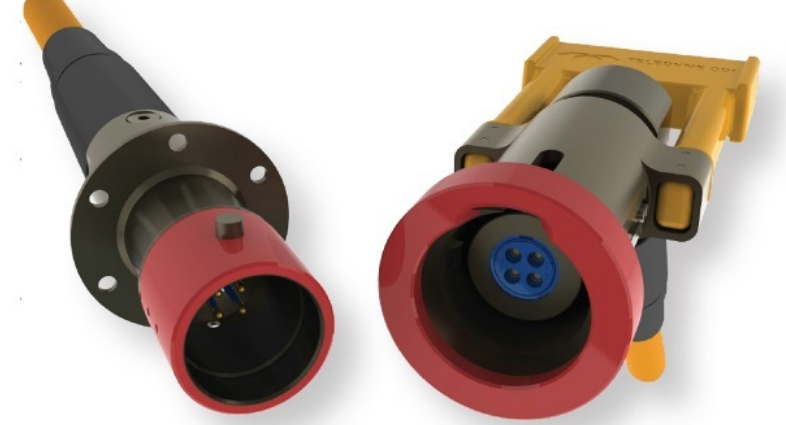
Figure 5. The Nautilus TM WM1.7-30 WMC [39].